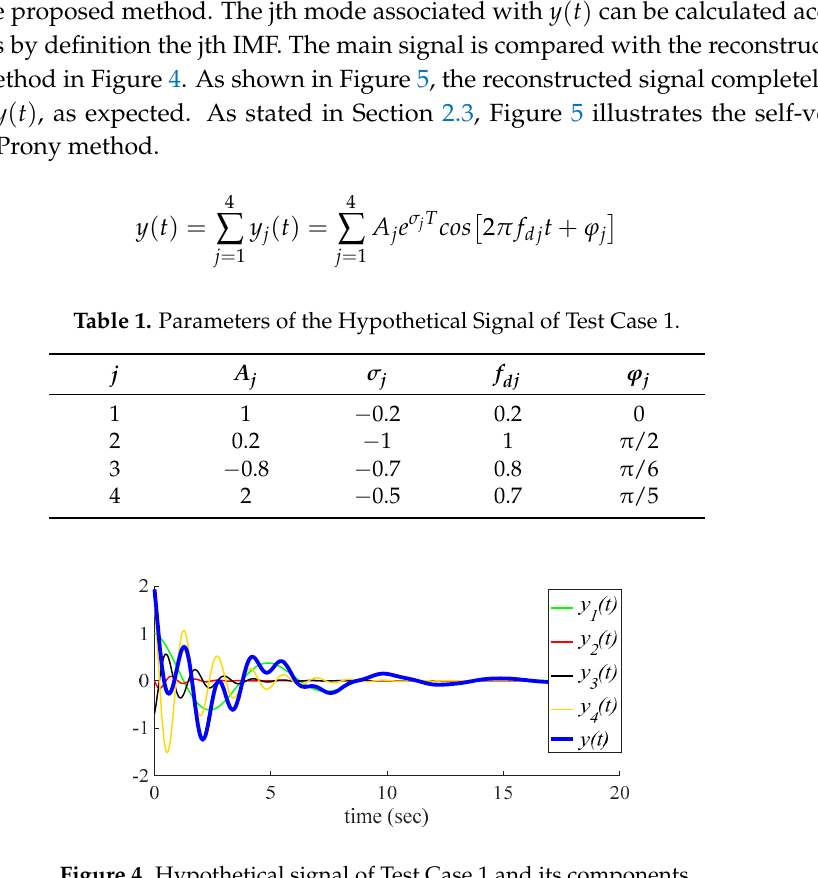
Figure 5. Comparison of real and reconstructed signals in Test Case 1. The modes of the signal 𝑦(𝑡) obtained by the Prony method are compared with real modes in Table 2. Observe that the Prony method is capable to extract modes accurately. The IMFs of the hypothetical signal are shown in Figure 6. Observe that extracted IMFs from our proposed mathematical method in Section 2.4 are exactly the same as real IMFs ( 𝑦 (cid:3037) (𝑡); 𝑗 = 1, … ,4) . Thus, our mathematical formulation computes IMFs of a given signal with high accuracy, without a need for heuristic algorithms such as those employed in the HHT method. Also, as illustrated in Figure 6, the proposed method represents IMFs of a given signal, in order of increasing damping for them. In other words, IMF of a more dominant mode or equivalently less damped ones will be represented first in our methodology. Therefore, in the Test Case 1, IMF (cid:2869) to IMF (cid:2872) are corresponding to 𝑦 (cid:2869) , 𝑦 (cid:2872) , 𝑦 (cid:2871) , and 𝑦 (cid:2870) in the hypothetical signal of (20), respectively, shown in Figure 4. H y